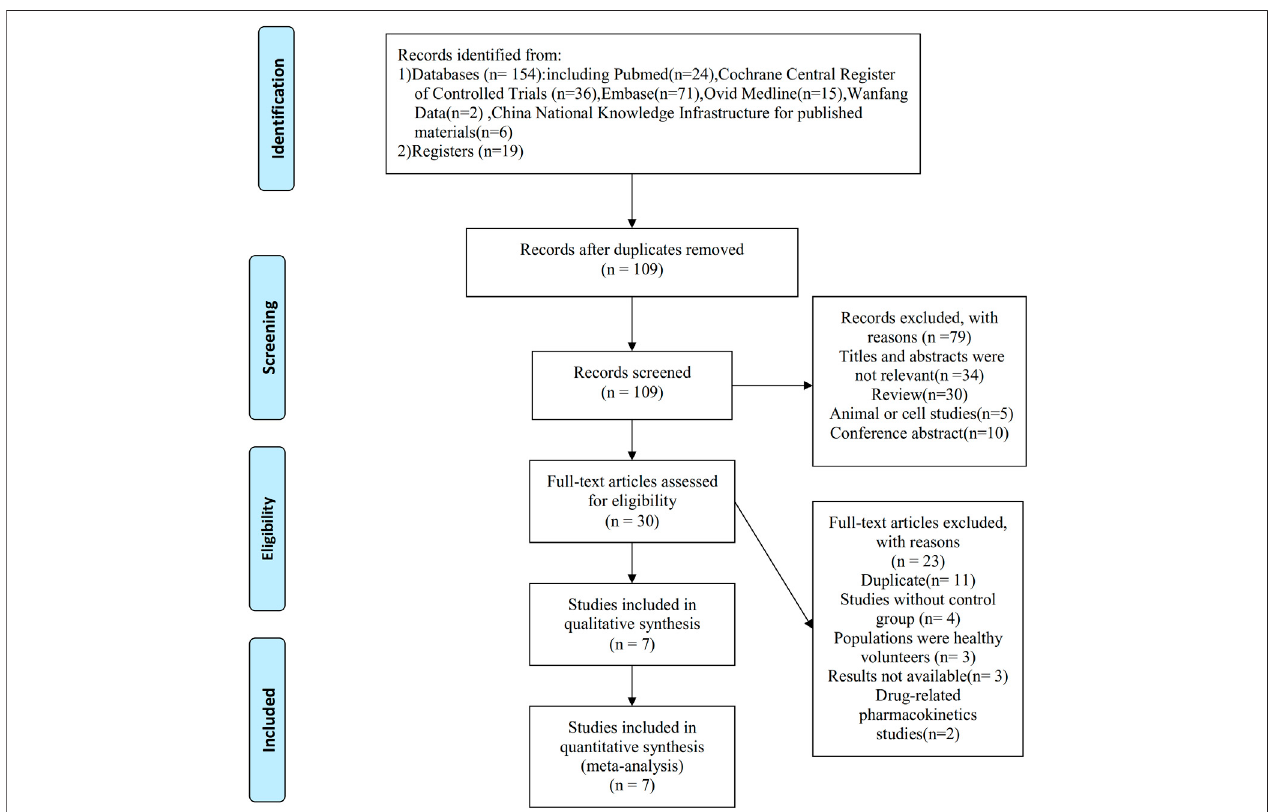
FIGURE 1 | Flowchart demonstrating the process of study